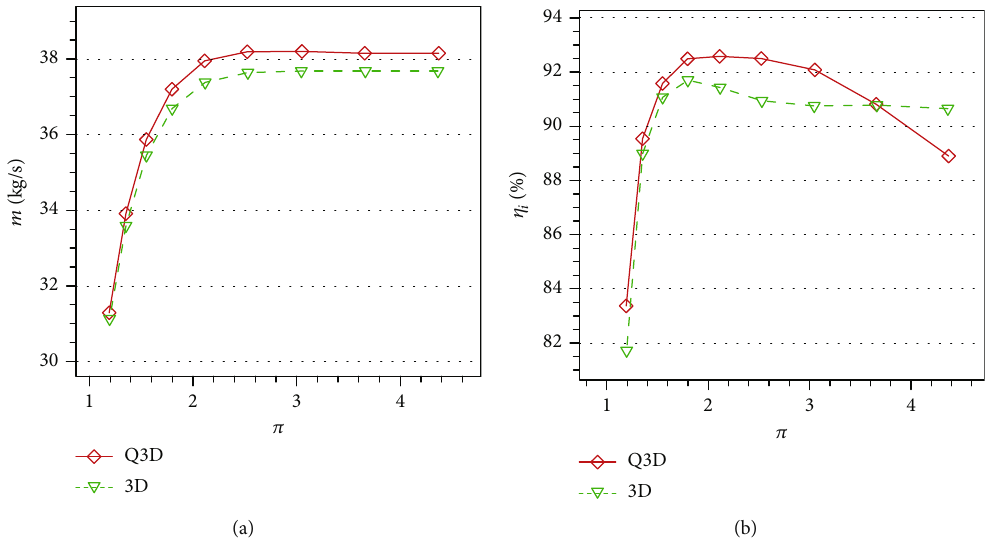
Figure 23: Characteristic curves of the single-stage turbine: (a) mass fl ow rate; (b) e ffi